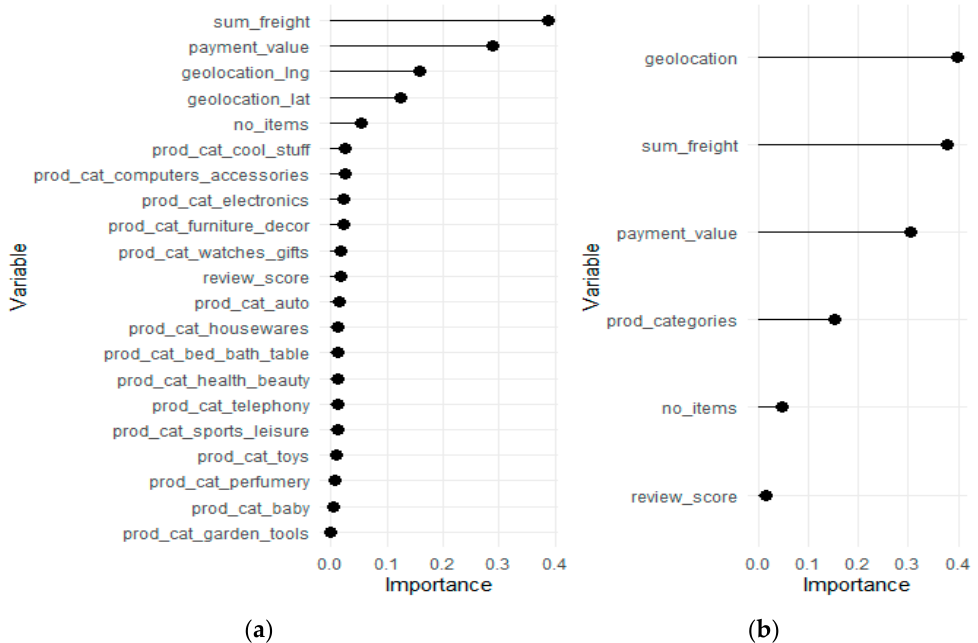
Figure 12. Variable importance plots for the model with all variables: ( a ) individual variables, ( b ) groups of variables.